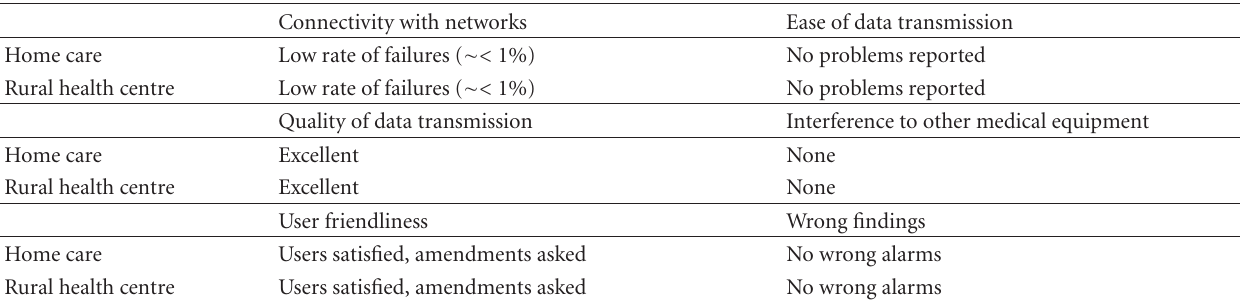
Table 2: Overview of technical metrics of Tile-Ippokratis